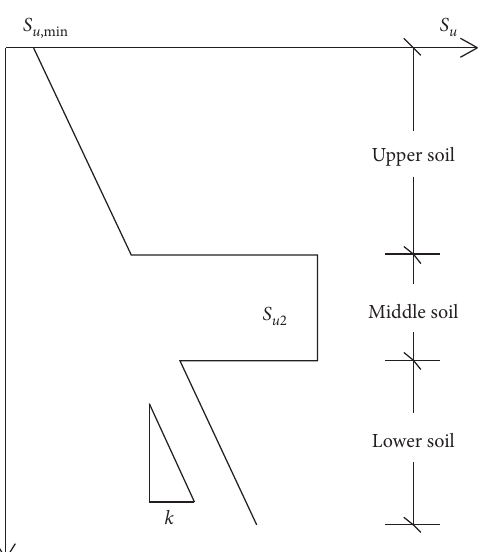
Figure 2: Layered soil parameters.